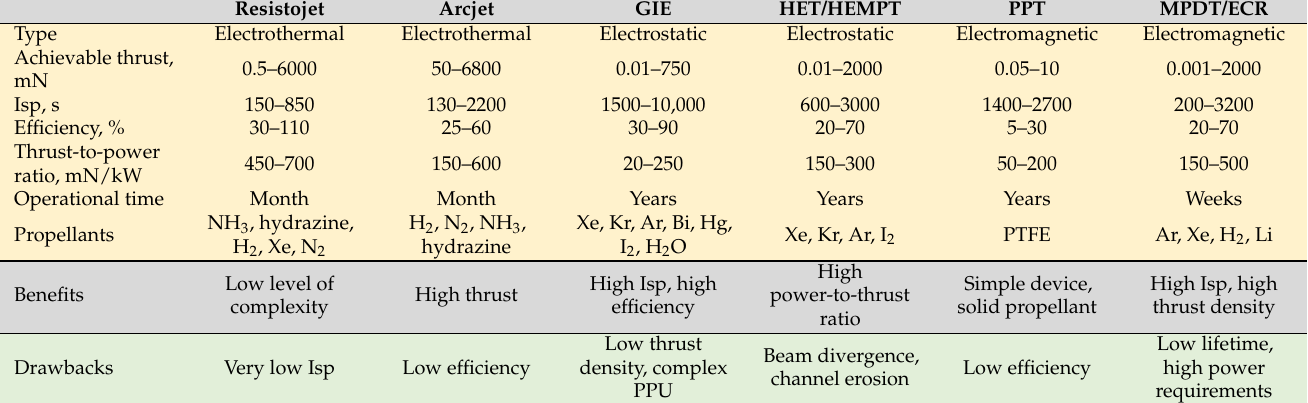
Table 1. Principal characteristics of the main EP thruster types (see detailed description in